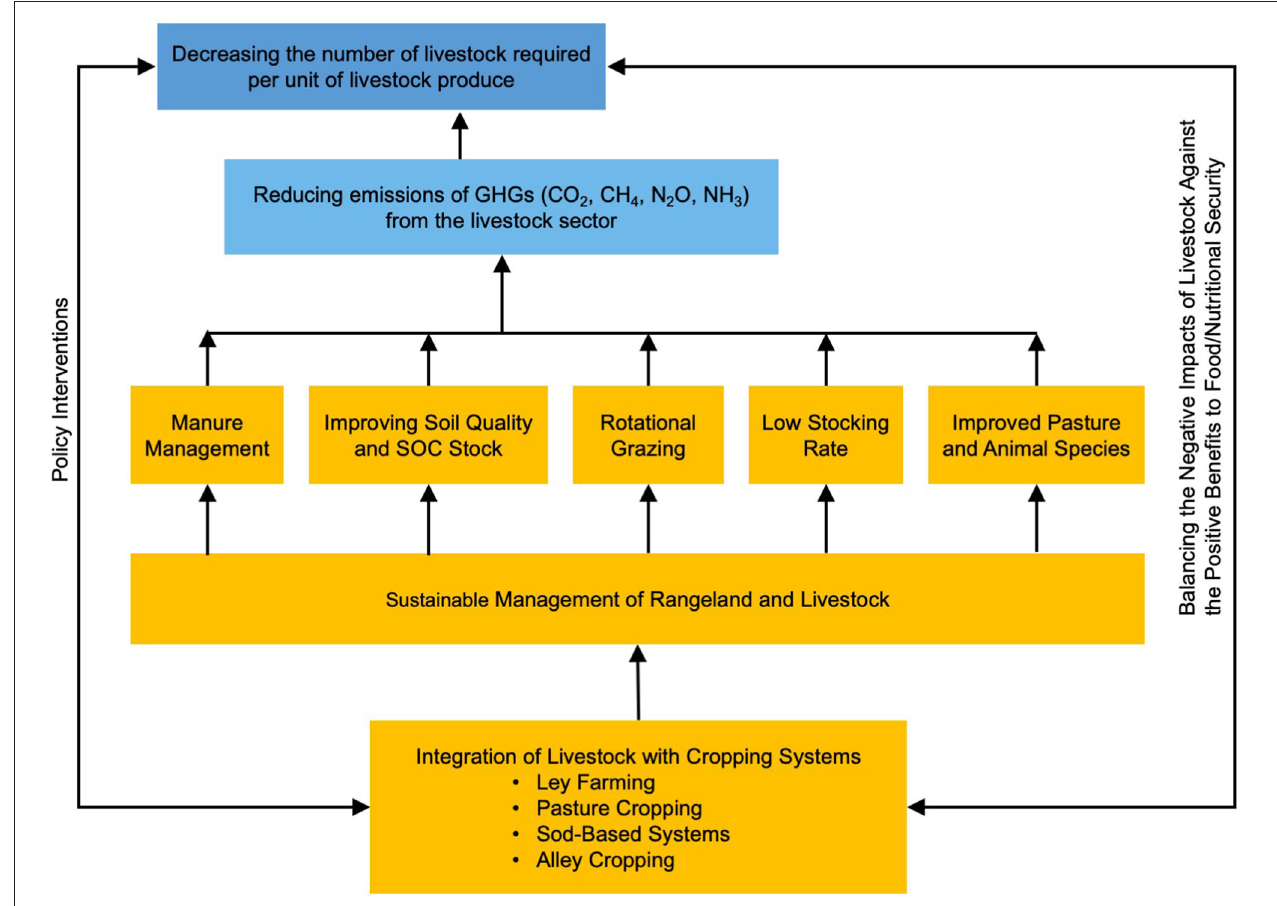
FIGURE 2 | A flow chart depicting the integration of livestock with arable land use for decreasing the number of livestock required (SOC, soil organic carbon; GHGs, greenhouse